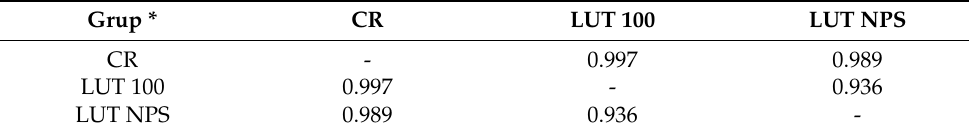
Table 5. Comparison of post hoc FOXO-3 results (ng/mg protein) with regard to the batch of the Figure 3. ( a ) Mean values of OXSR1 (mg/mg protein), TAC (ng/mg protein), FOXO-3 (ng/mg protein) in lutein nanoparti- cles-treated oral cancer cells, and control cells (Lut Nps—oral cancer squamous cells incubated with lutein nanoparticles;